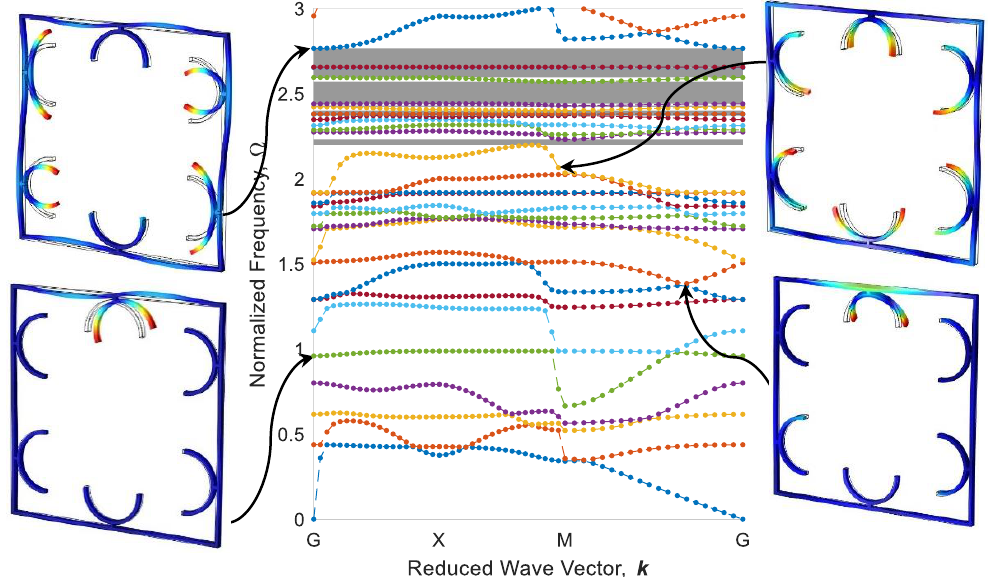
Figure 19. The counterpart of Figure 17 for 40 mm / s.